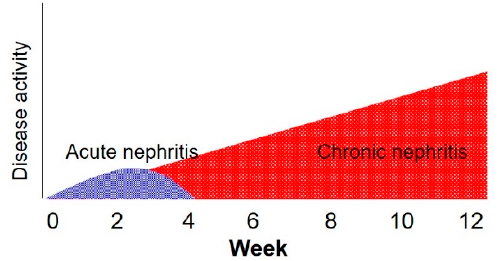
Figure 1. Schematic illustration of the definition of acute and chronic nephritis.